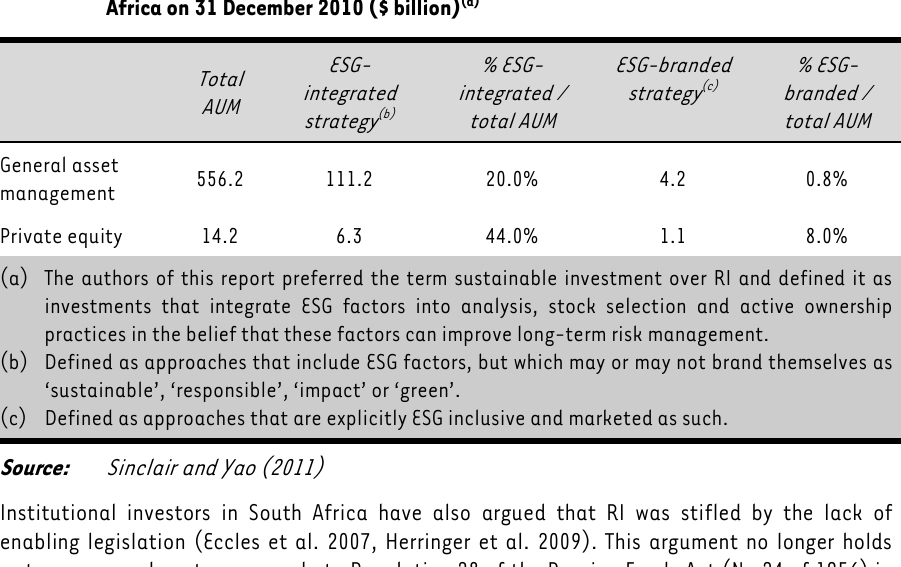
TABLE 1: Estimates of professional sustainable investment assets under management in South Africa on 31 December 2010 ($ billion)